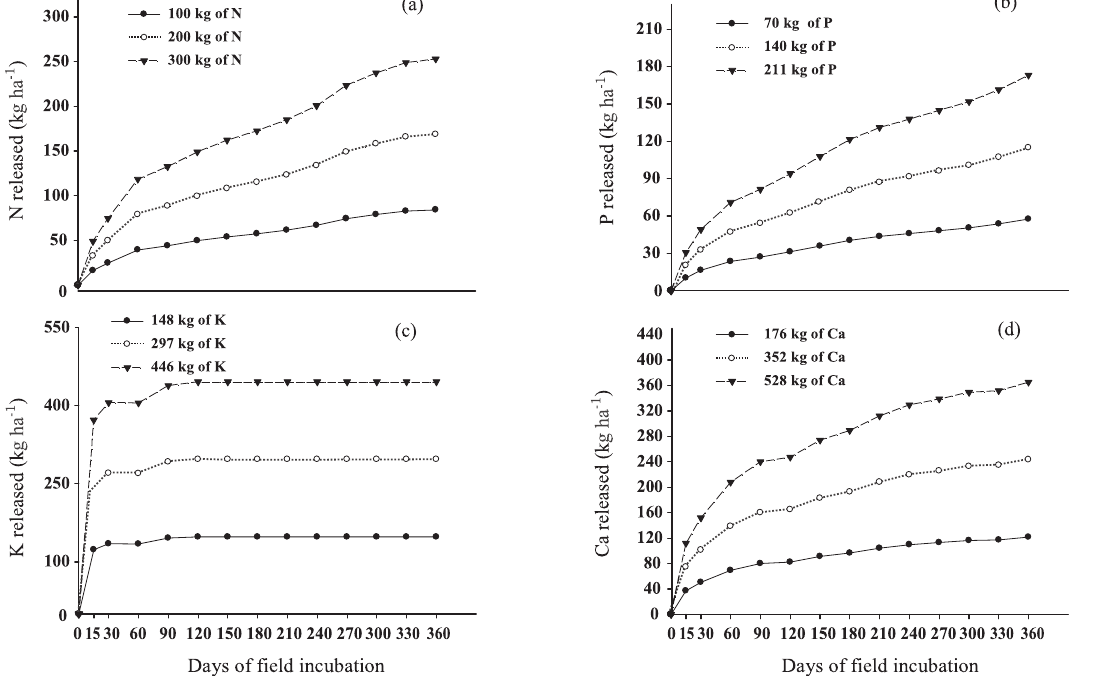
Figure 4. accumulated release (kg ha -1 ) of nitrogen (a), phosphorus (b), potassium (d) and calcium (d) from poultry litter amounts (4,953, 9,907 and 14,860 kg ha -1 ) after periods up to one year of field incubation in litter